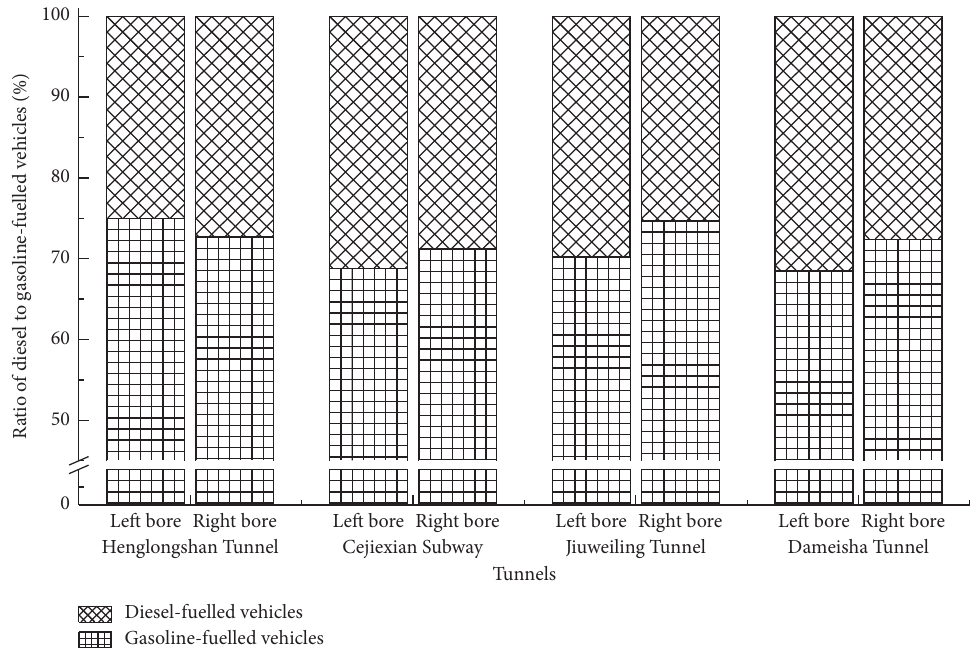
Figure 7: The proportions of diesel to gasoline-fuelled vehicles in the four urban